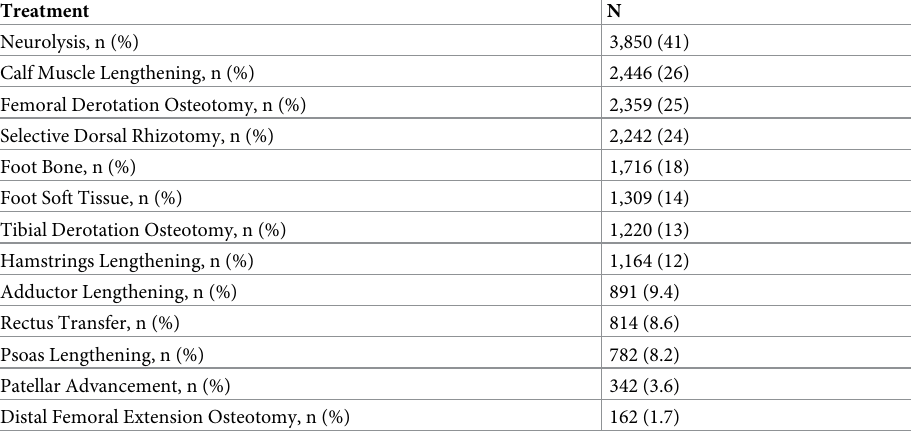
Table 2. History of prior